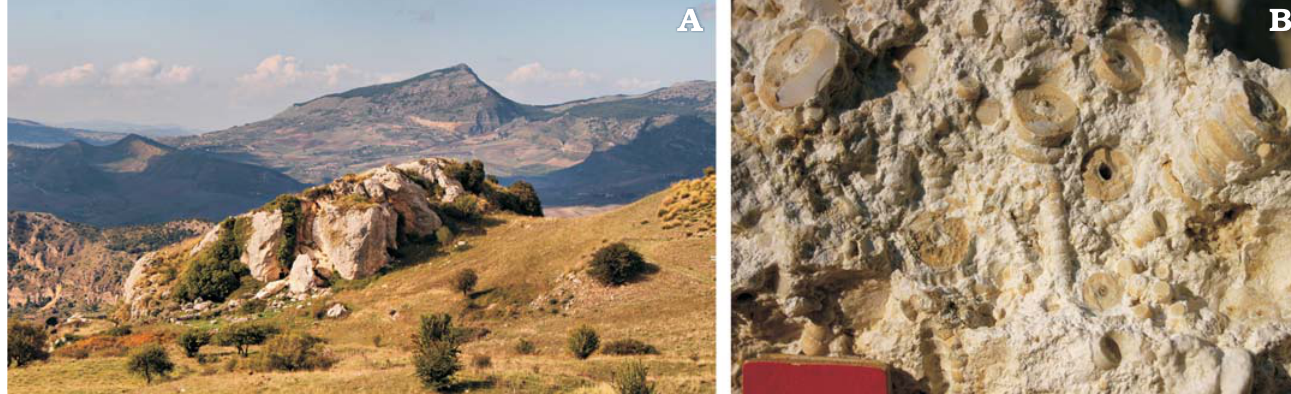
Fig. 2. A . The general appearance of the Pietra di Salomone megablock viewed from the East. B . Detail of the rock at mesoscale. Scale bar 30 mm.